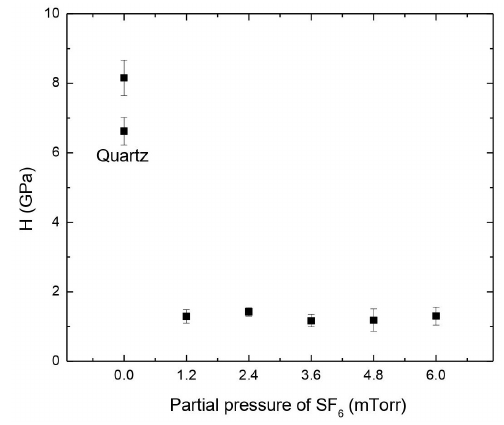
Figure 13. Hardness as a function of R